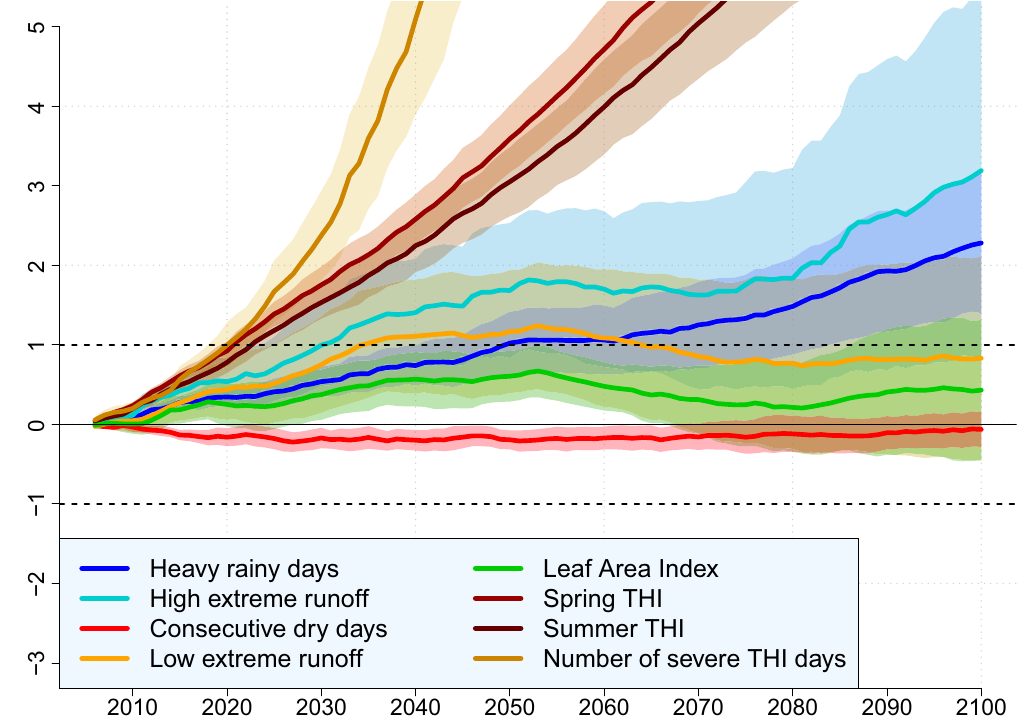
Figure 4. Timeseries of the eight selected climate stressors between 2005 and 2100 averaged over grid points where at least 5 of them are projected to significantly intensify under the RCP8.5 scenario. For each indicator and for each year, values are obtained by dividing the corresponding 20-y upcoming projected change compared to the 1979–2005 period by the 1979–2005 standard-deviation (std). Solid lines indicate the multi-model means for each indicator. Shaded colors display the confidence interval among the models for each impact indicator (see Table S1 for models set for each